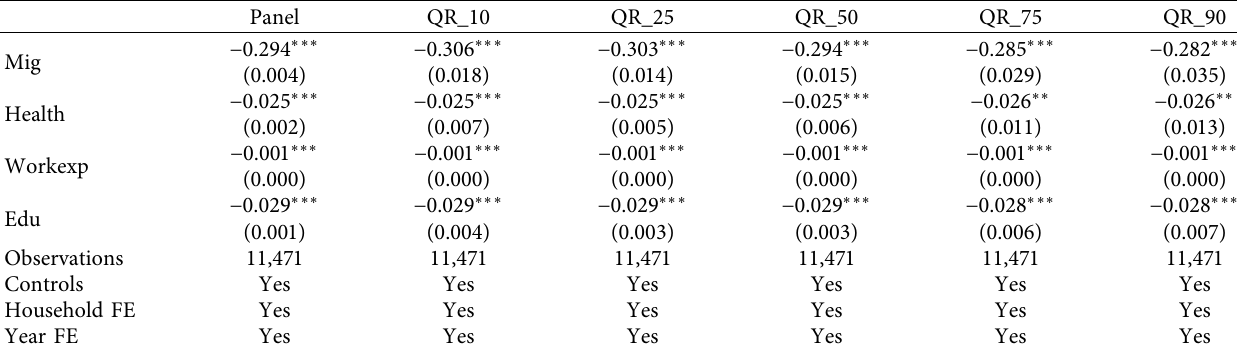
Table 2: The impact of human capital on vulnerability to relative